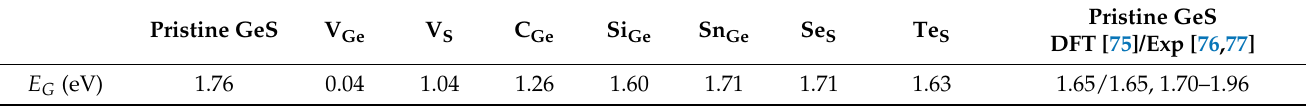
Figure 4. Total DOS and PDOS of monolayer pristine GeS and defective GeS: ( a ) pristine GeS, ( b ) GeS with vacancy at S site ( V S ) , ( c ) GeS with substitutional atoms at S site (Se S and Te S ) , ( d ) GeS with vacancy at Ge site ( V Ge ) , and ( e ) GeS with substitutional atoms at Ge site ( C Ge ,Si Ge ,Sn Ge ) . The black line represents total DOS, while the colored PDOS lines represents contributions by the atoms shown in the same color in the inset. Table 1. Bandgaps obtained from DFT calculations for GeS without and with